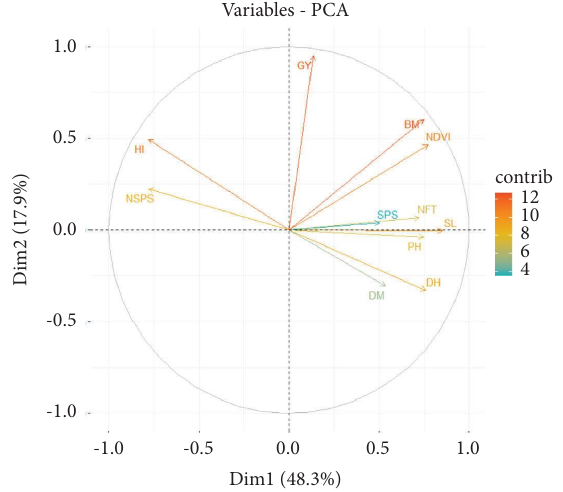
Figure 8: Phenotypic correlations between grain yield and phe- nological, yield components, and physiological traits of 200 durum wheat genotypes evaluated under optimum N conditions at three locations.